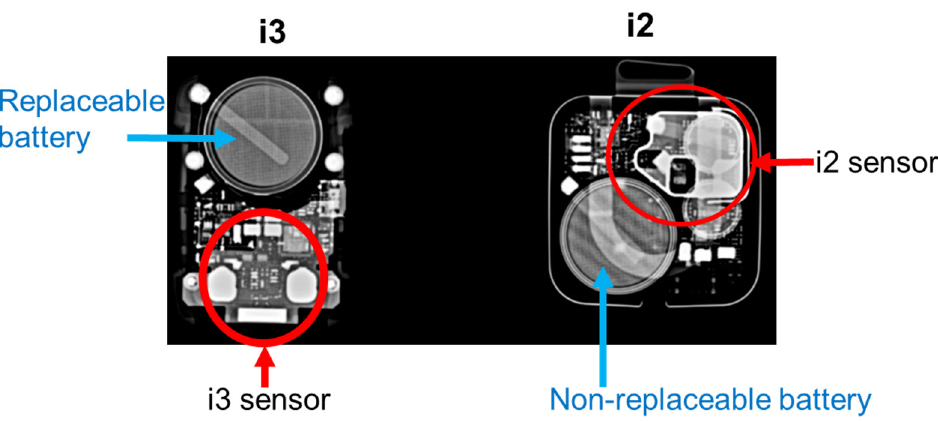
Figure 10. X-ray photographs for the i3 and i2 dosimeters.